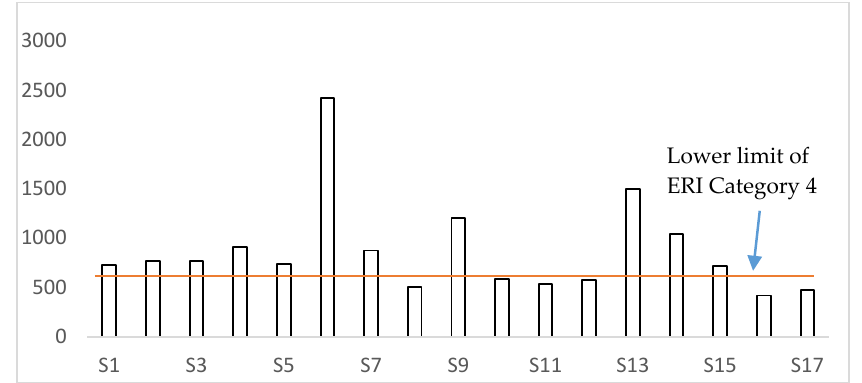
Figure 3. Comparison of ERI among the 17 sampling locations in the investigated area.